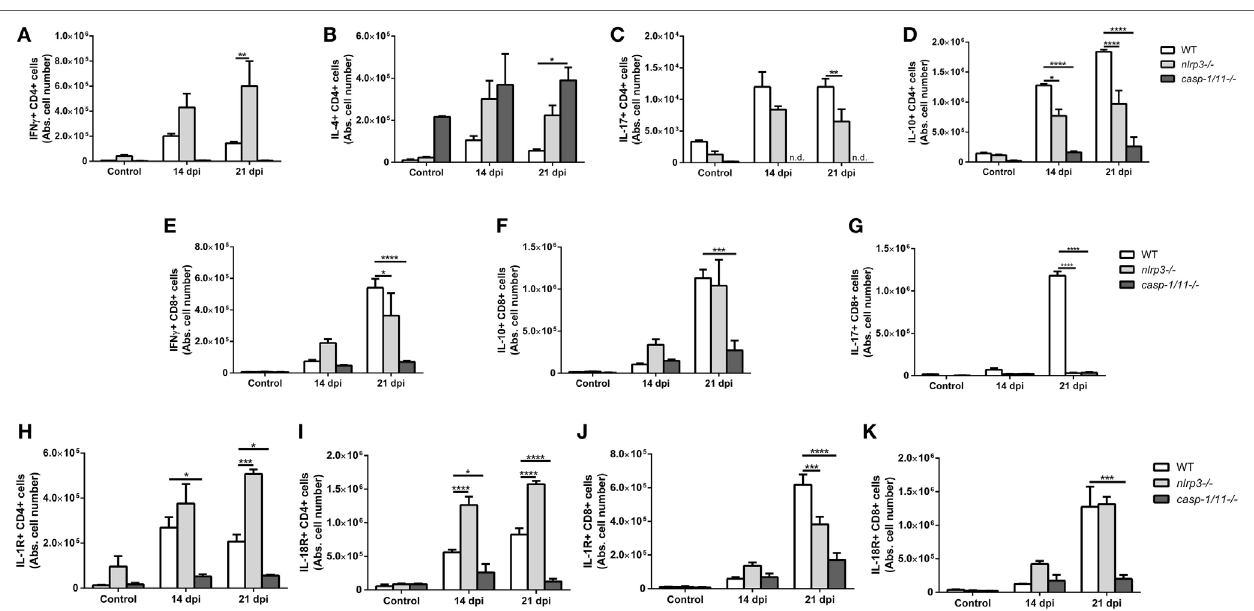
FigUre 4 | Infected NLRP3 and caspase-1/11-deficient mice differentially modulate T helper and T cytotoxic lymphocyte phenotypes during Trypanosoma cruzi infection. Intracellular cytokines were determined in hepatic leukocytes obtained at 14 and 21 days post infection by flow cytometry. Absolute number of hepatic (a) IFN γ+ , (B) IL-4 + , (c) IL-17 + , and (D) IL-10 + in CD4 + T lymphocytes are shown. Absolute number of hepatic (e) IFN γ+ , (F) IL-10 + , and (g) IL-17 + in CD8 + T lymphocytes are shown. Absolute number of (h) IL-1R + and (i) IL-18R + on CD4 + T lymphocytes. Absolute number of hepatic (J) IL-1R + and (K) IL-18R + on CD8 + T lymphocytes. Data are shown as mean ± SEM from one of three representative experiments; n = 3–6 mice per group. Statistical significance was evaluated by two-way ANOVA followed by Bonferroni post hoc test. * p < 0.05; ** p < 0.01; *** p < 0.001; **** p <